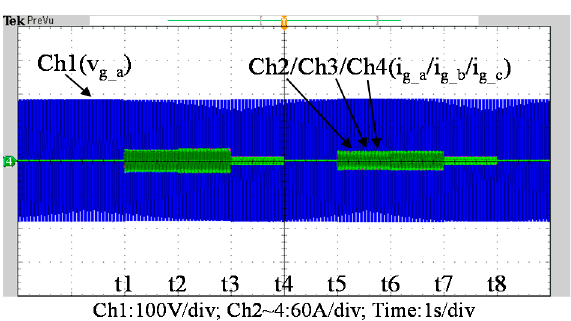
Figure 33. Waveforms of grid phase-a voltage and three-phase currents.